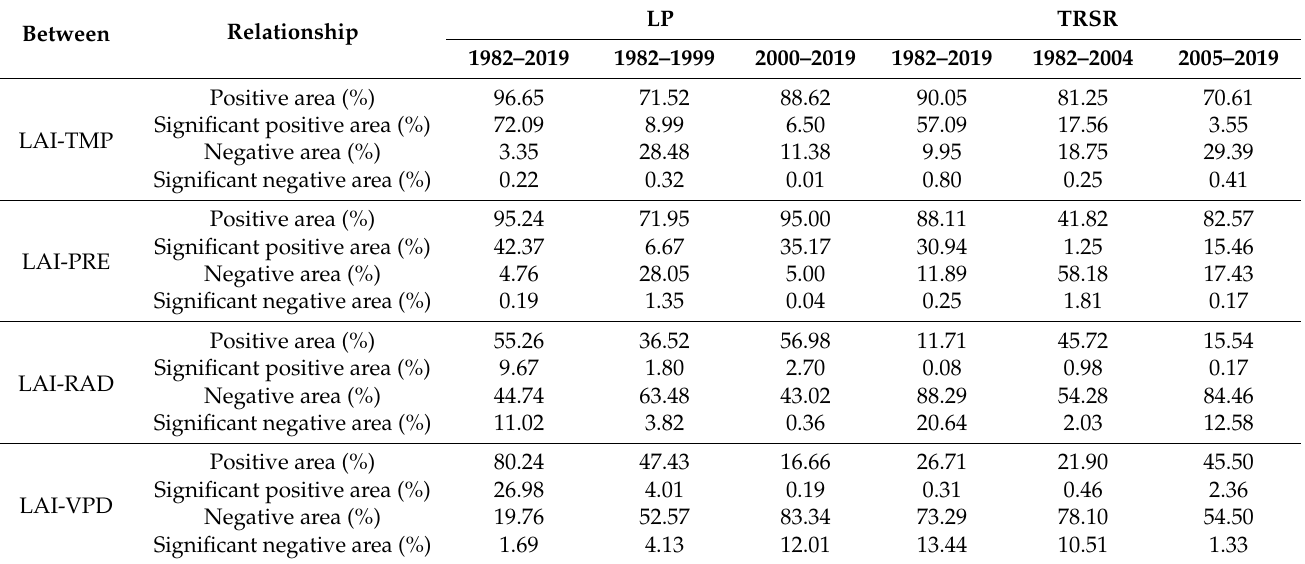
Table 3. Summary of the correlations between LAI and TMP, PRE, RAD, and VPD in the study regions.